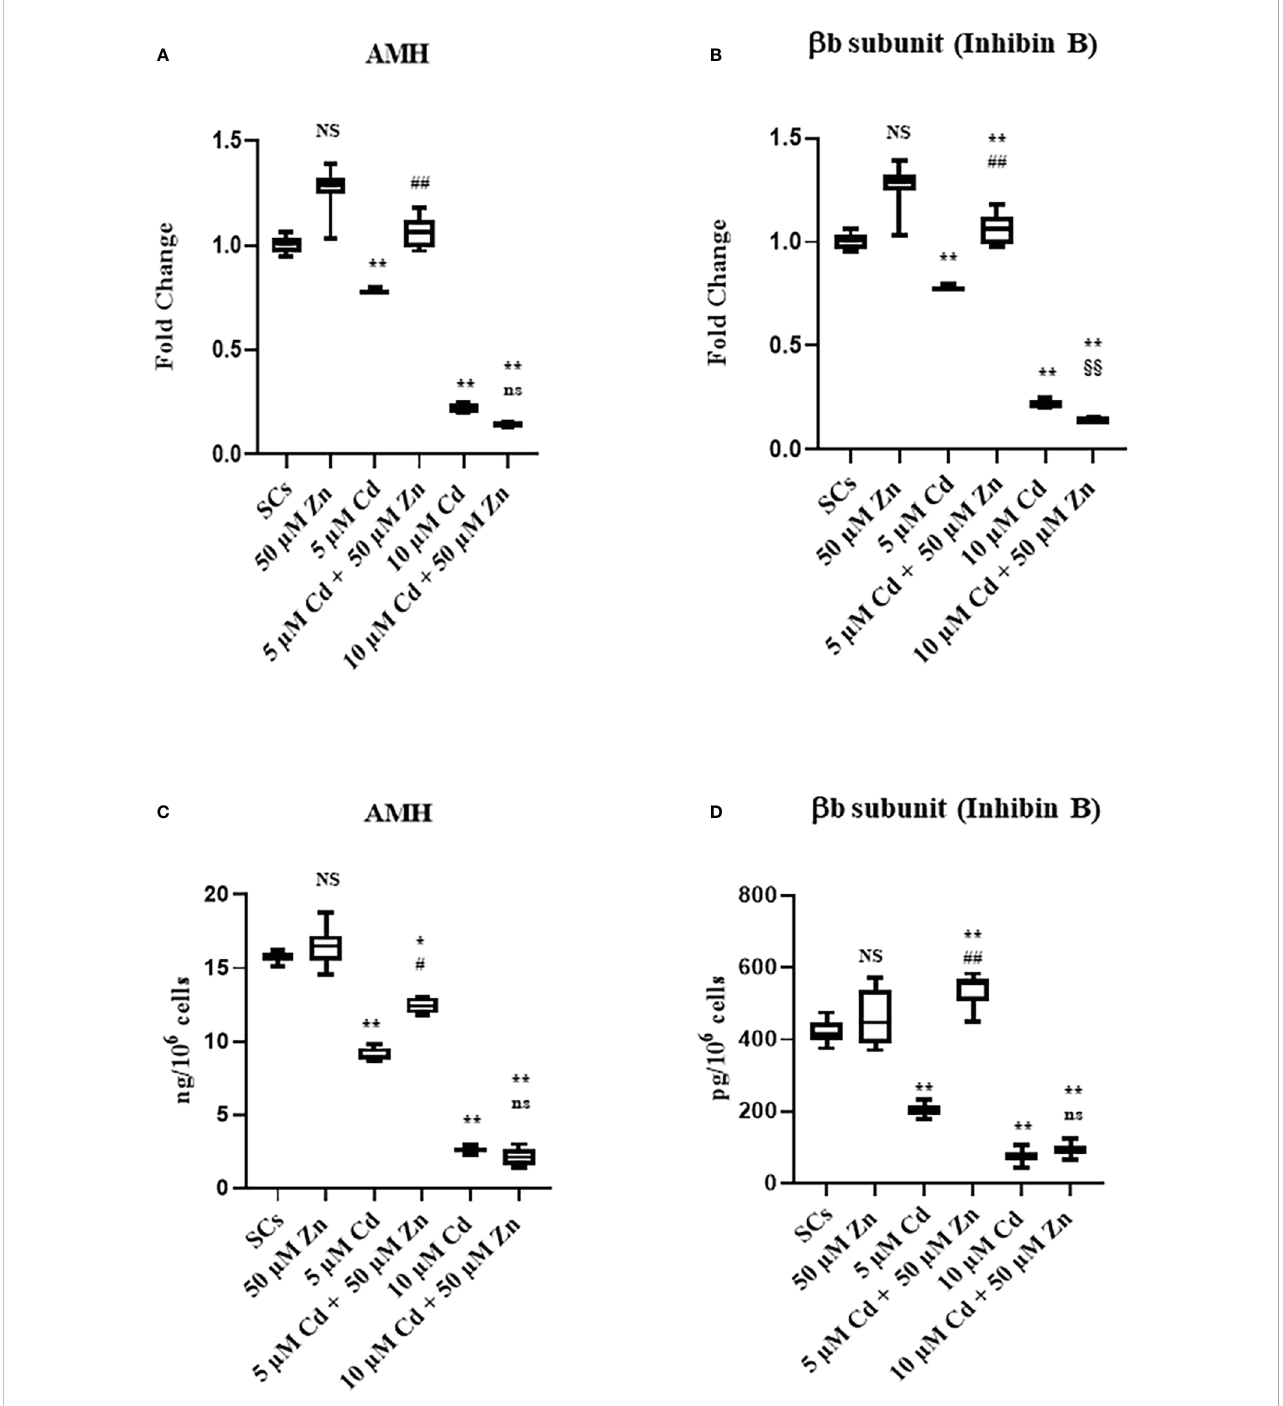
FIGURE 4 Gene expression and protein secretion of AMH (A, C) , and b B subunit (Inhibin B) (B, D) in the absence (unexposed-control group, SCs) or presence of 5 or 10 µM CdCl2 and/or 50 µM ZnCl2 for 48 h. Data represent the mean ± S.E.M. (Not signi fi cant, NS). NS vs SCs, *p<0.05 and **p<0.001, #p<0.05 and #p<0.05 vs 5 µM Cd, §p<0.05 vs 10 µM, (not signi fi cant, ns) ns vs 10 µM of three independent experiments, each performed in